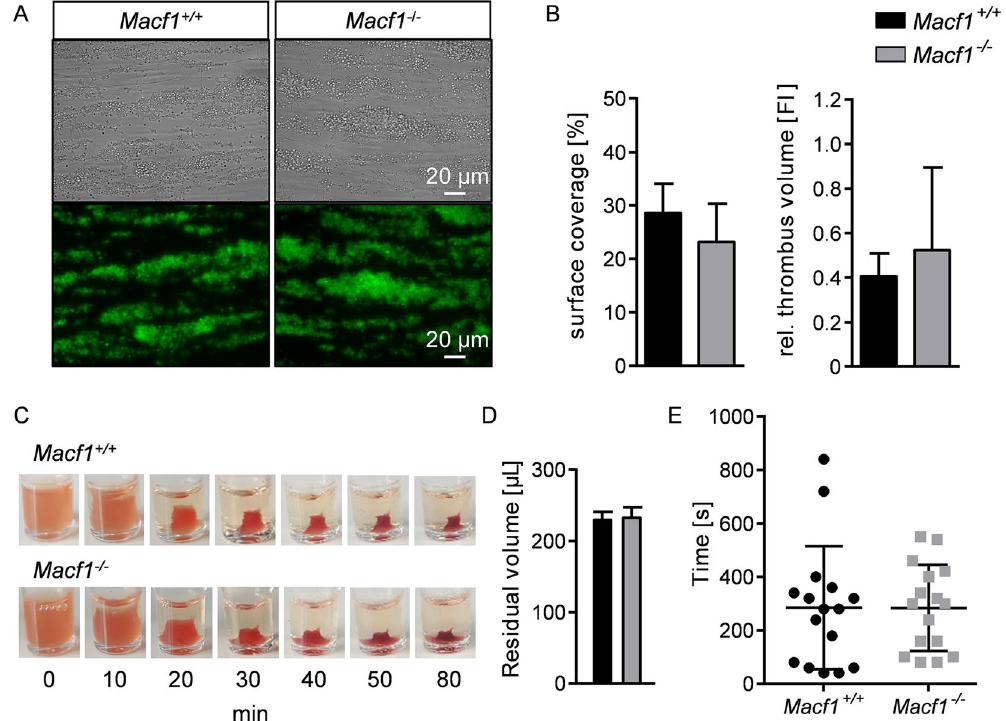
Figure 4. MACF1 is not important for thrombus formation, clot retraction and hemostasis. (A) Thrombus formation was assessed on collagen at a wall shear rate of 1,000 s − 1 . Shown are representative bright field (upper panel) and fluorescence (lower panel) pictures of platelets stained with a Dylight-488 anti-GPIX antibody. (n = 6, representative for two independent experiments) (B) Surface coverage and relative thrombus volume was quantified according to fluorescence distribution and fluorescence intensity, respectively. (C) Clot formation was observed over time and (D) residual serum volume was measured. (n = at least 3, representative for three independent experiments) (E) Determination of tail bleeding time performed on filter paper of Macf1 + / + and Macf1 − / −